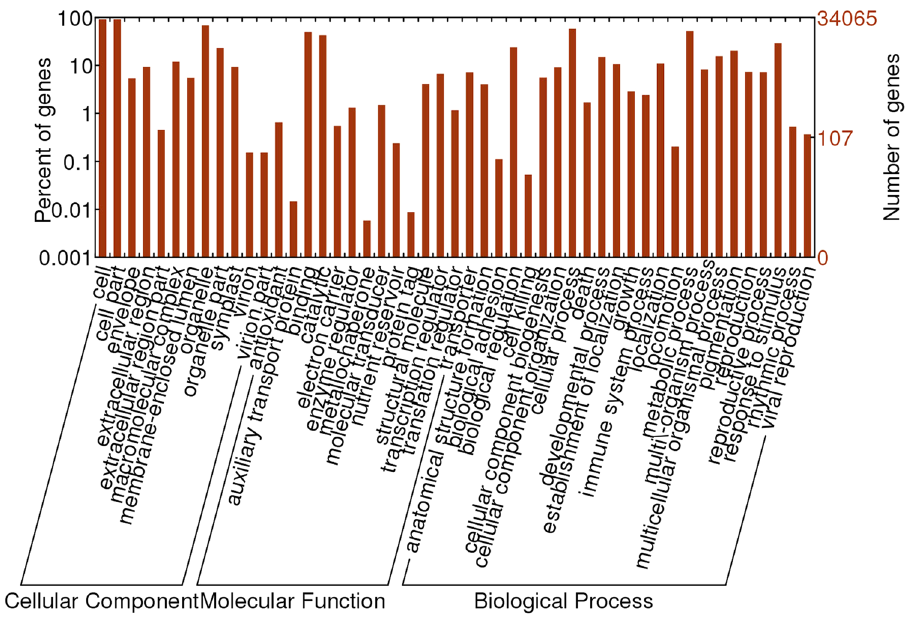
Figure 1. GO classification of annotated transcriptomic genes. Three levels (Biological Process, Molecular Function and Cellular Component) were demonstrated. The 34,065 transcripts were distributed among 49 GO terms.